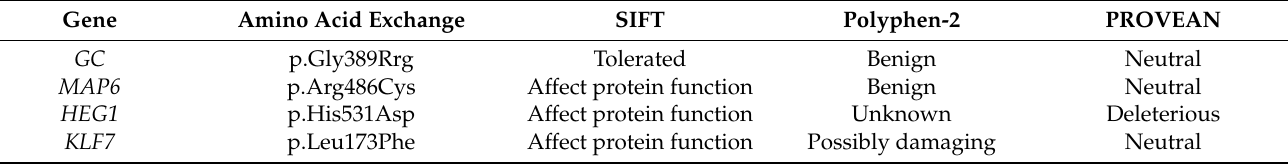
Table 4. Variant effect predicted by SIFT, PolyPhen-2, and PROVEAN.